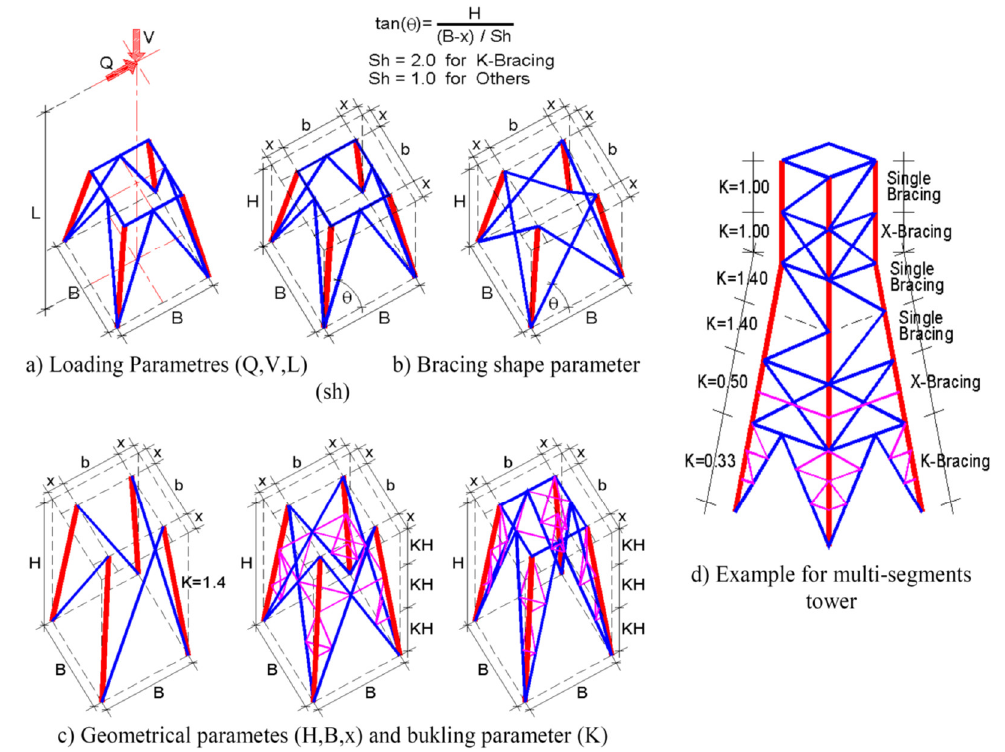
Figure 2. Geometrical and loading parameters.